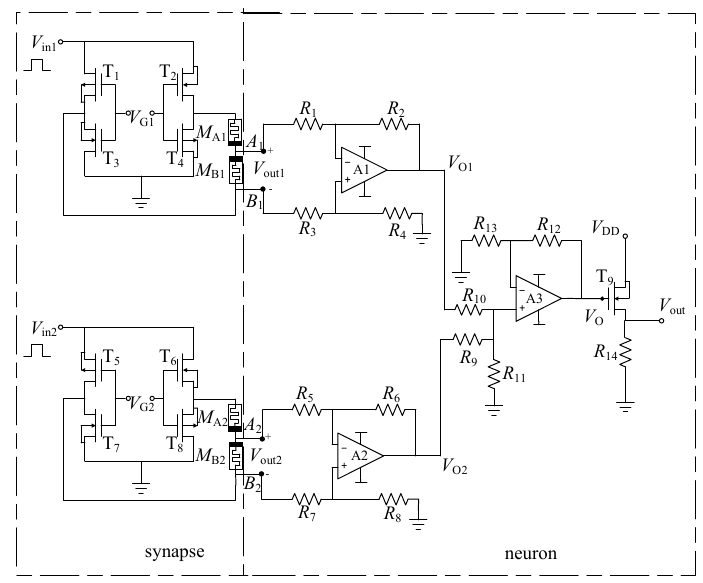
Table 2. Comparison of memristive synaptic circuits.